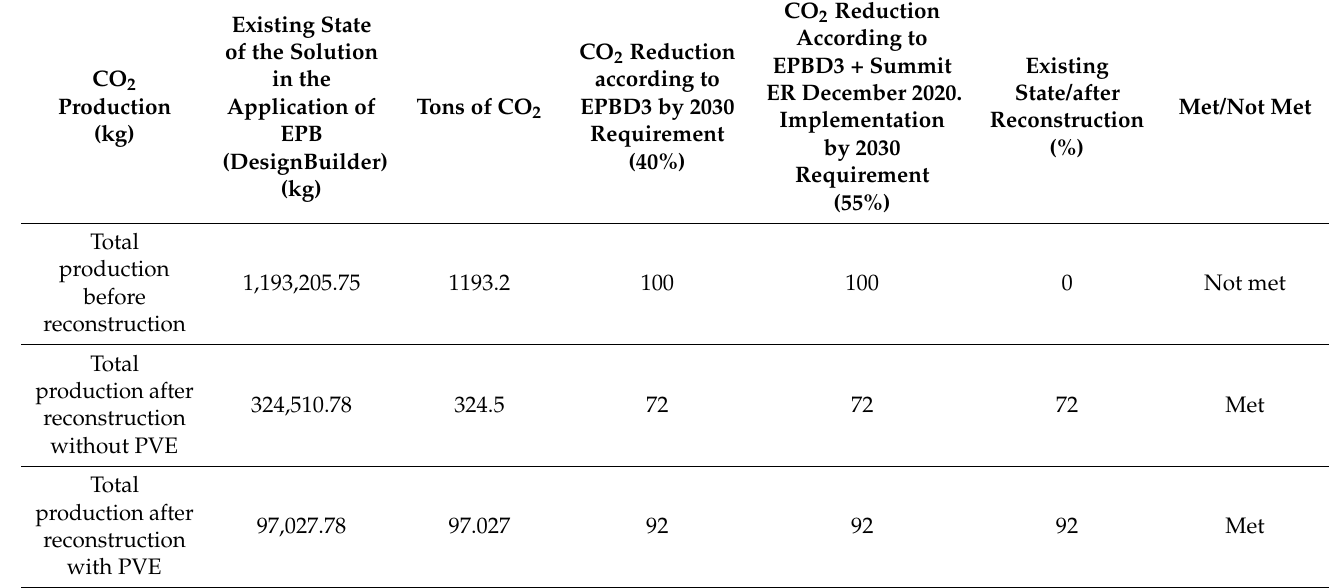
Table 24. Evaluation of CO 2 production before and after the reconstruction of the urban area by DB